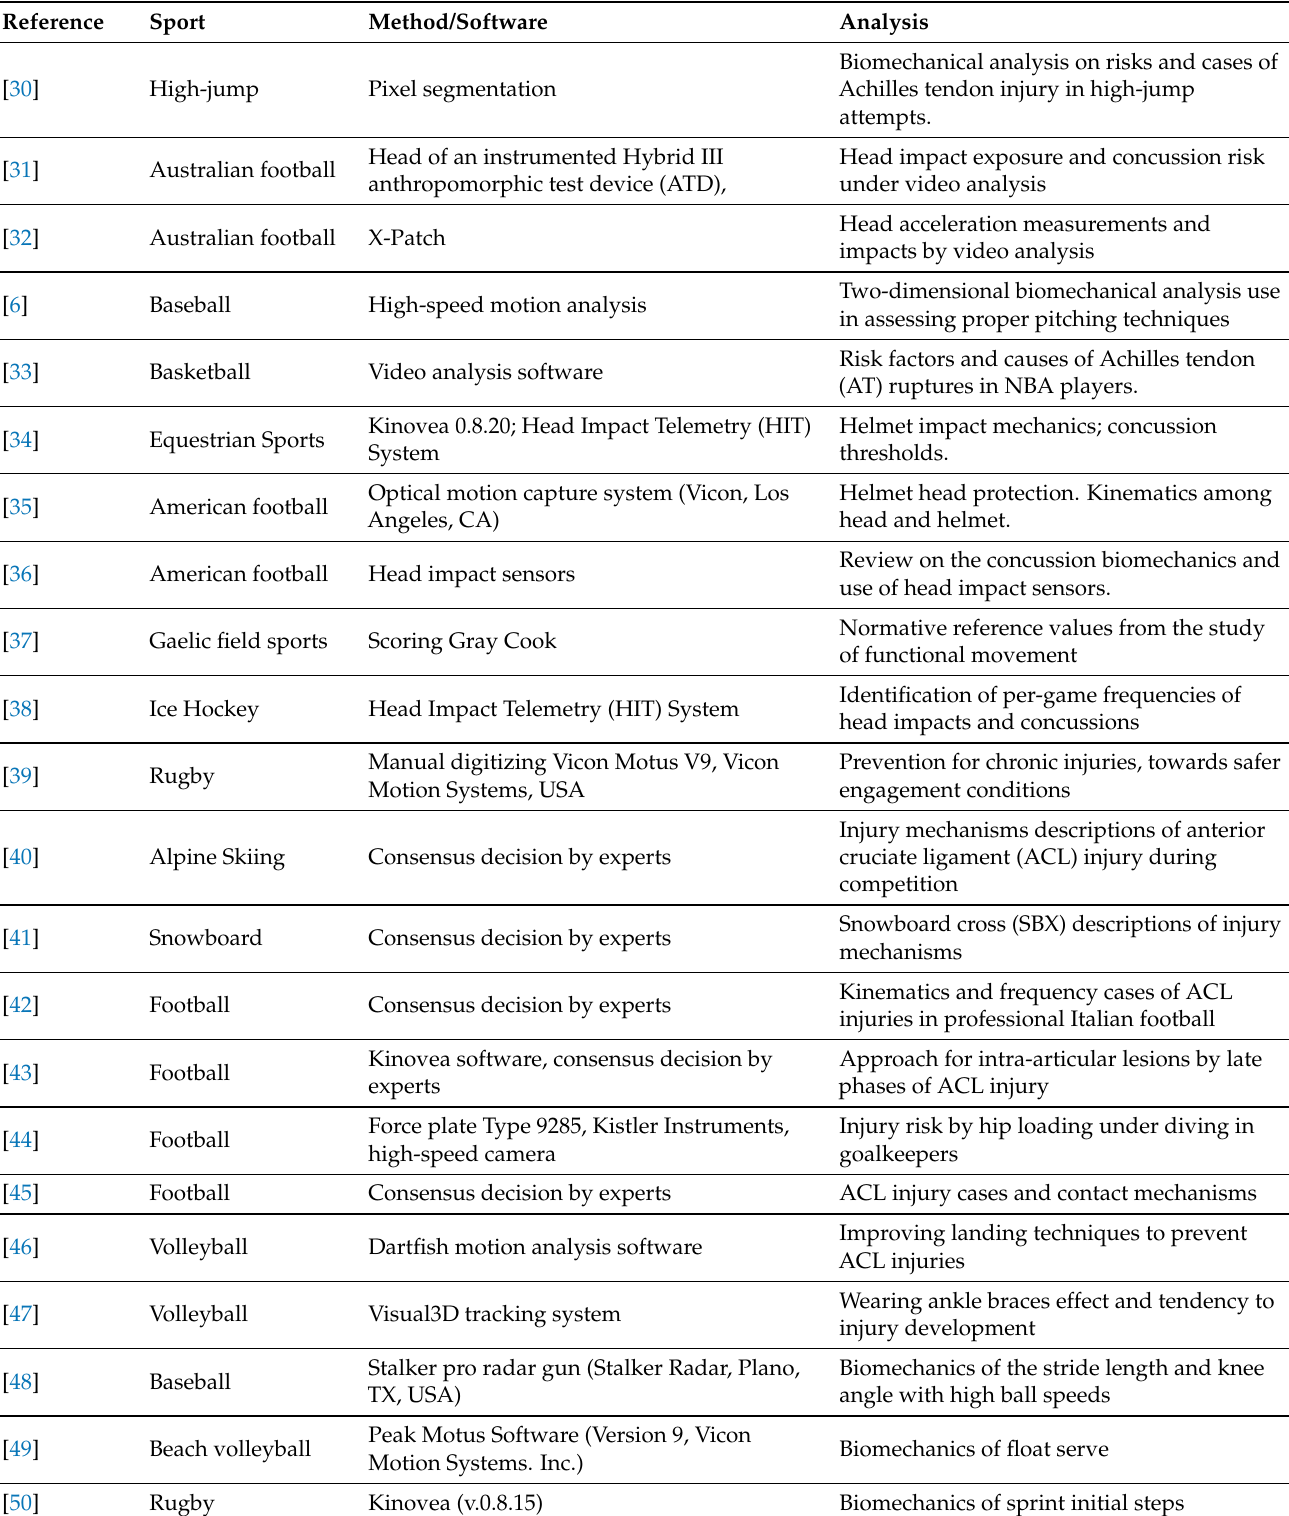
Table 1. Video-based biomechanics tools reported in the literature. For each specific study, the Sport, Method/Software and Analysis implemented is